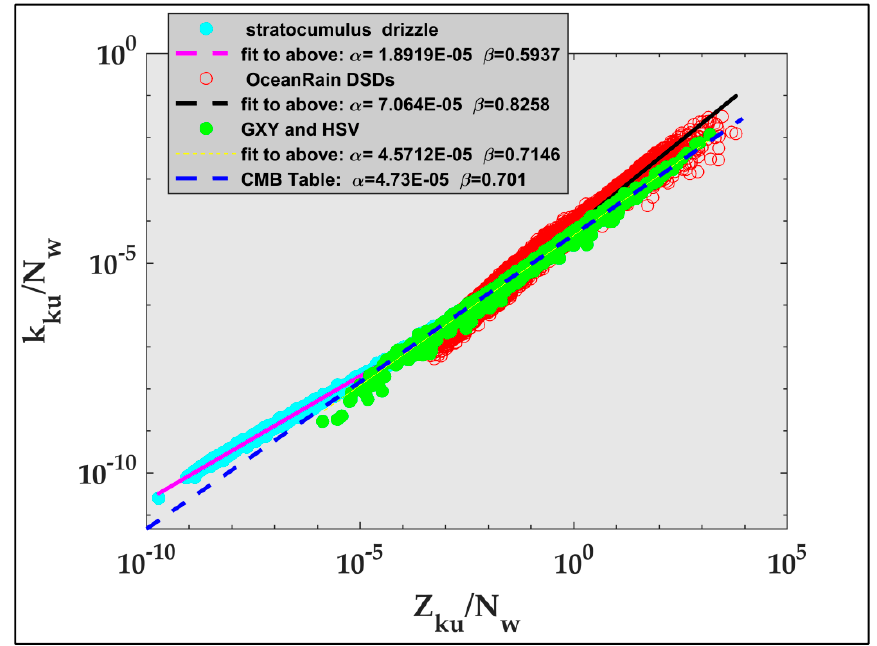
Figure 12. Variation of Ku-band specific attenuation (k ku in dB km − 1 ) normalized by N W (mm − 1 m − 3 ) versus Ku-band reflectivity (Z ku , in mm 6 m − 3 ) normalized by N W . See legend, which lists the regimes.